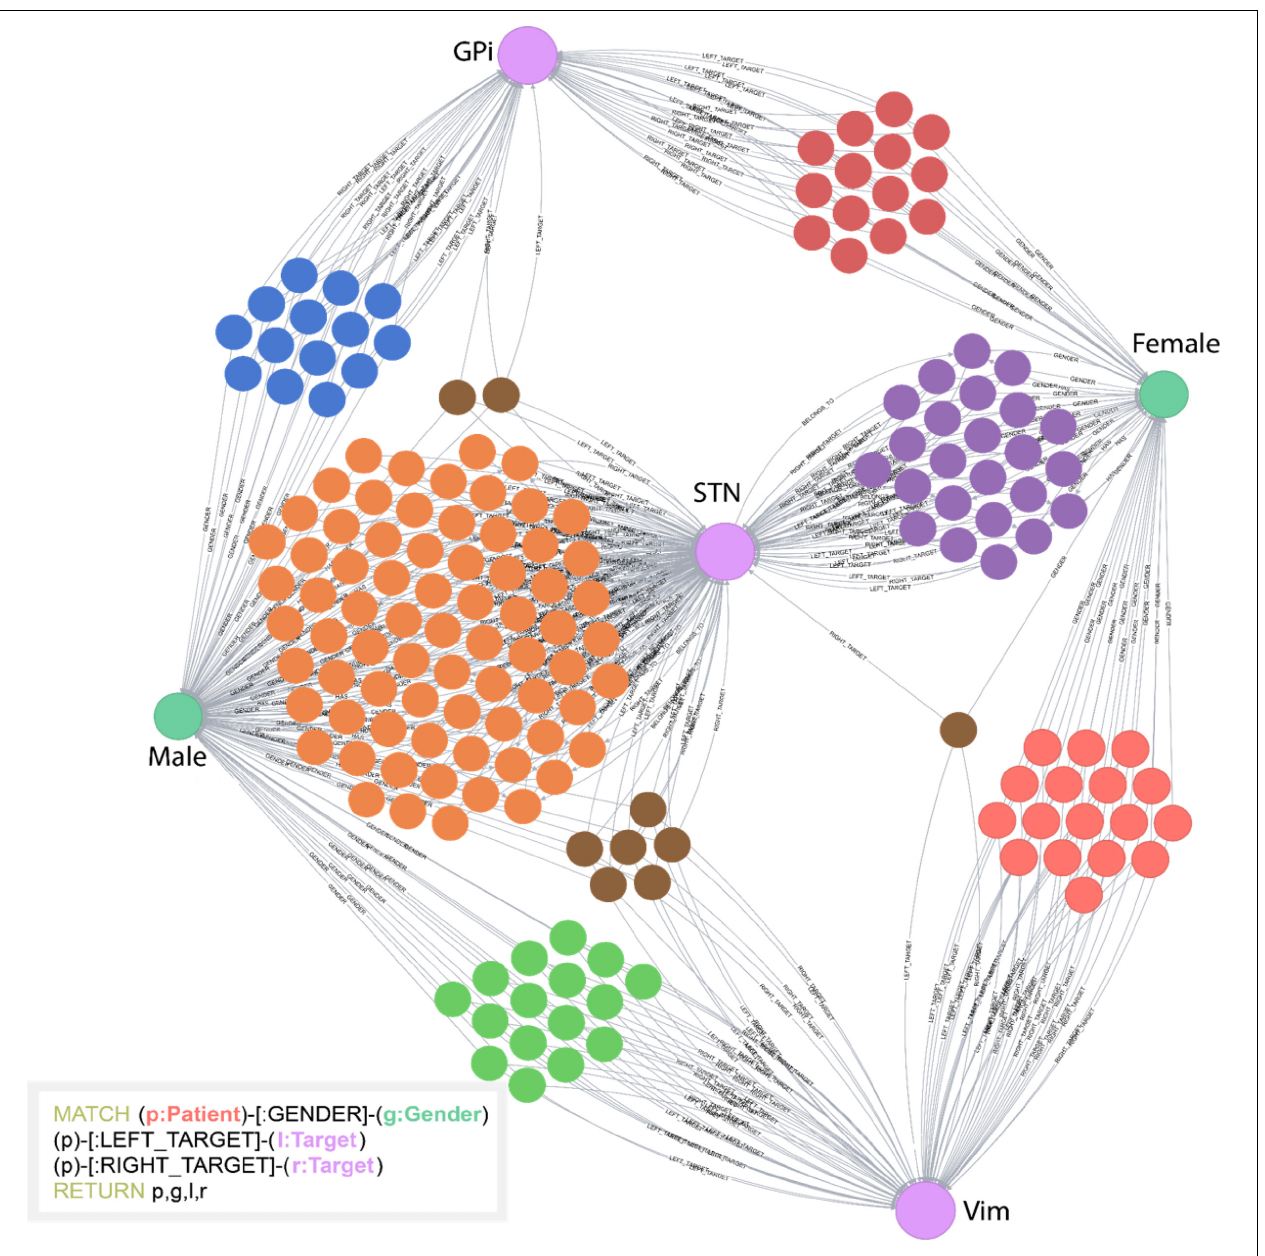
FIGURE 3 | Example of a Cypher query and the visual result. In this example, the database was queried to return patients (unlabeled, multicolored nodes), gender (Male or Female), and stimulation targets (GPi, STN, or Vim). All unlabeled nodes represent individual patients. This simple example highlights how visual clustering analysis can easily be done using Cypher. The individual patient clusters share commonalities between the attributes selected. This helps users determine underlying structure of the